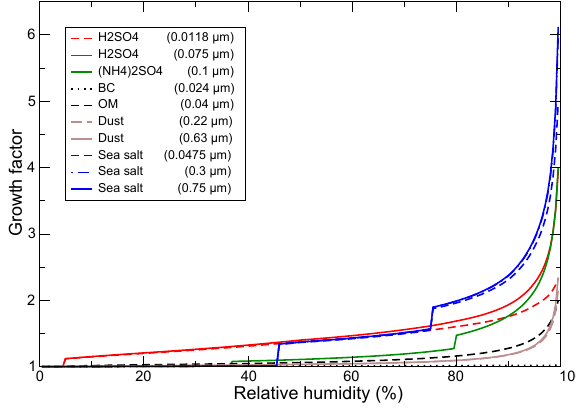
Figure 2. Hygroscopic growth factors (wet–ambient radius divided by dry radius) for aerosol components at some typical dry radii and for relative humidities up to RH max = 99 . 5%, as treated in AeroTab5.3 and the optics lookup tables. Note that the growth factor curve for sea salt at dry radius 0.3µm is not visible due to overlap with that for 0.75µm. To relate this figure to the nomenclature in Table 2, H 2 SO 4 (sulfuric acid) may come as SO4_NA, SO4_PR, or SO4_A1, ( NH 4 ) 2 SO 4 (ammonium sulfate) as SO4_A2, BC as BC_AX, BC_N, BC_NI, or BC_A, OM as OM_NI, OM_AI, SOA_NI, or SOA_A1, mineral dust as DST_A2 or DST_A3, and sea salt as SS_A1, SS_A2, or